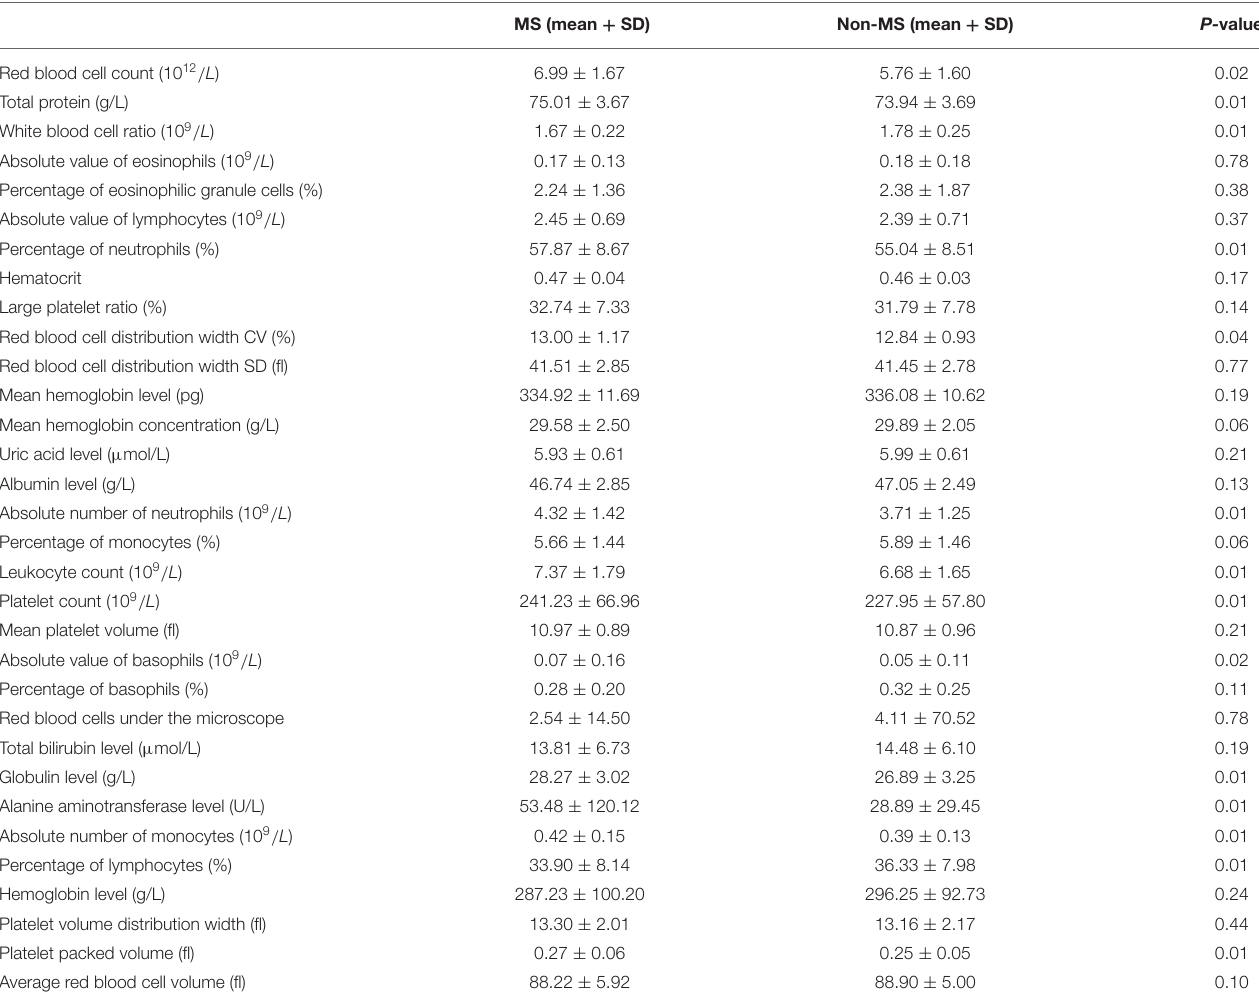
TABLE 3 | Basic characteristics of routine physical examination markers.